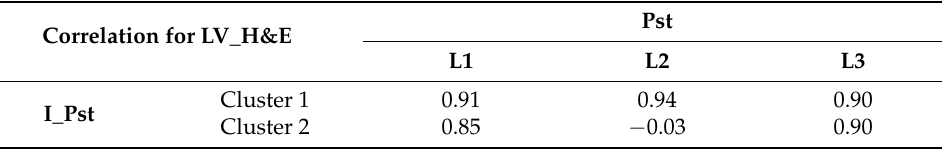
Table 3. Correlation between the flicker indicator and the short-term flicker severity in LV_H&E for different